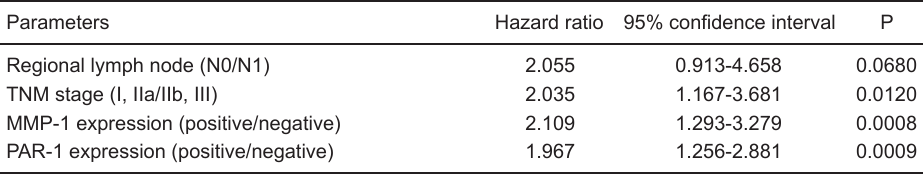
Table 3. Multivariate analysis of disease-free survival by Cox’s proportional hazard model.